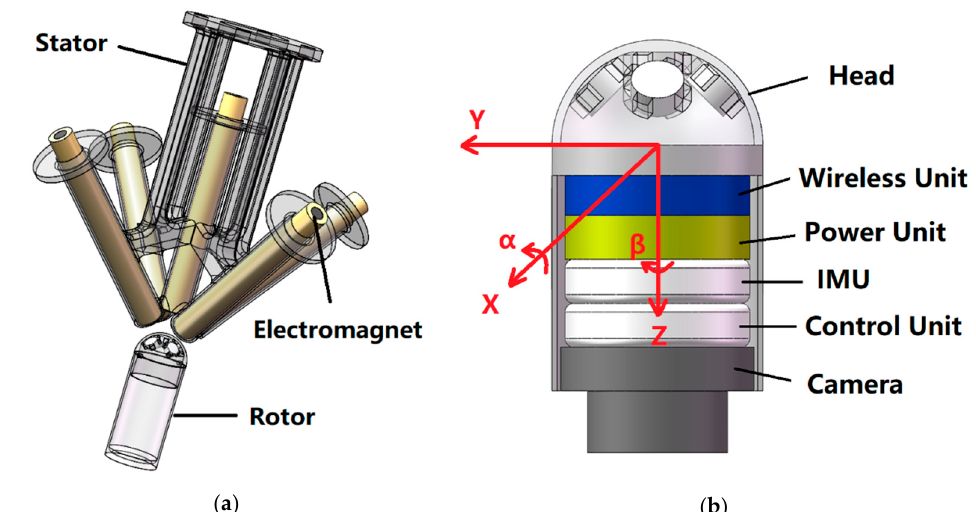
Figure 3. ( a ) shows the connection between rotor and stator. ( b ) shows the structure and degrees of freedom (DOFs) of the rotor. In the conceptual design, the rotor consists of a head, a wireless unit, a power unit, an IMU, a control unit, and a camera. In this paper, only the head is fabricated. The coordinate described in (b) is fixed to the center of the hemispherical head of the robot. 𝛼 indicates the deflection about the X or Y axis, while 𝛽 indicates the rotation about the z axis.